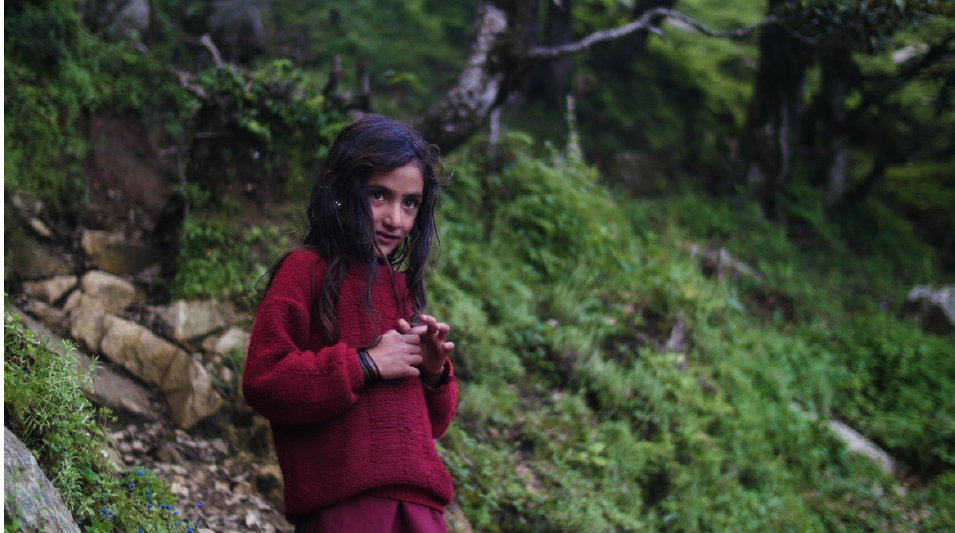
Figure 8. A Muslim Gurjar girl herds a flock near Shikari Devi. Credit: Nadav